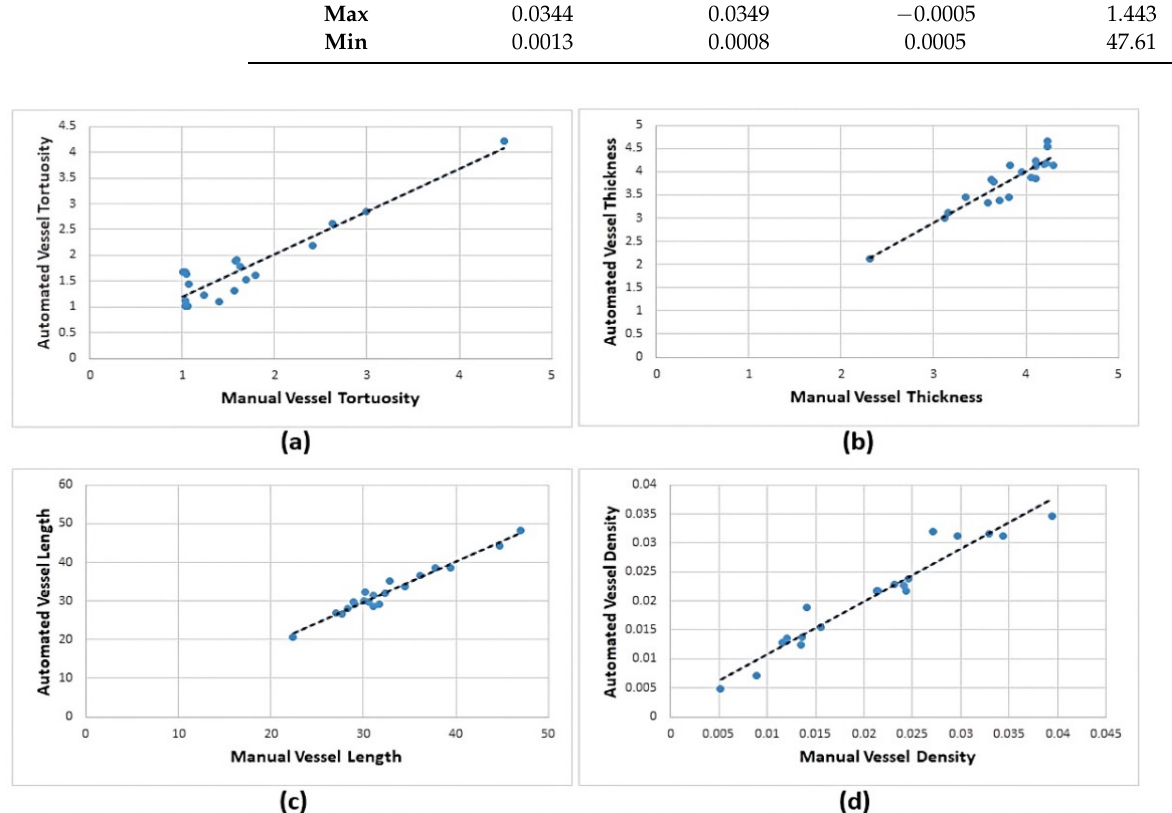
Figure 15. Correlation plots between manual use by the second human observer and automated clinical estimations from the DRIVE dataset using the proposed trainable filters algorithm: ( a ) tortuosity; ( b ) thickness; ( c ) length; and ( d ) density.